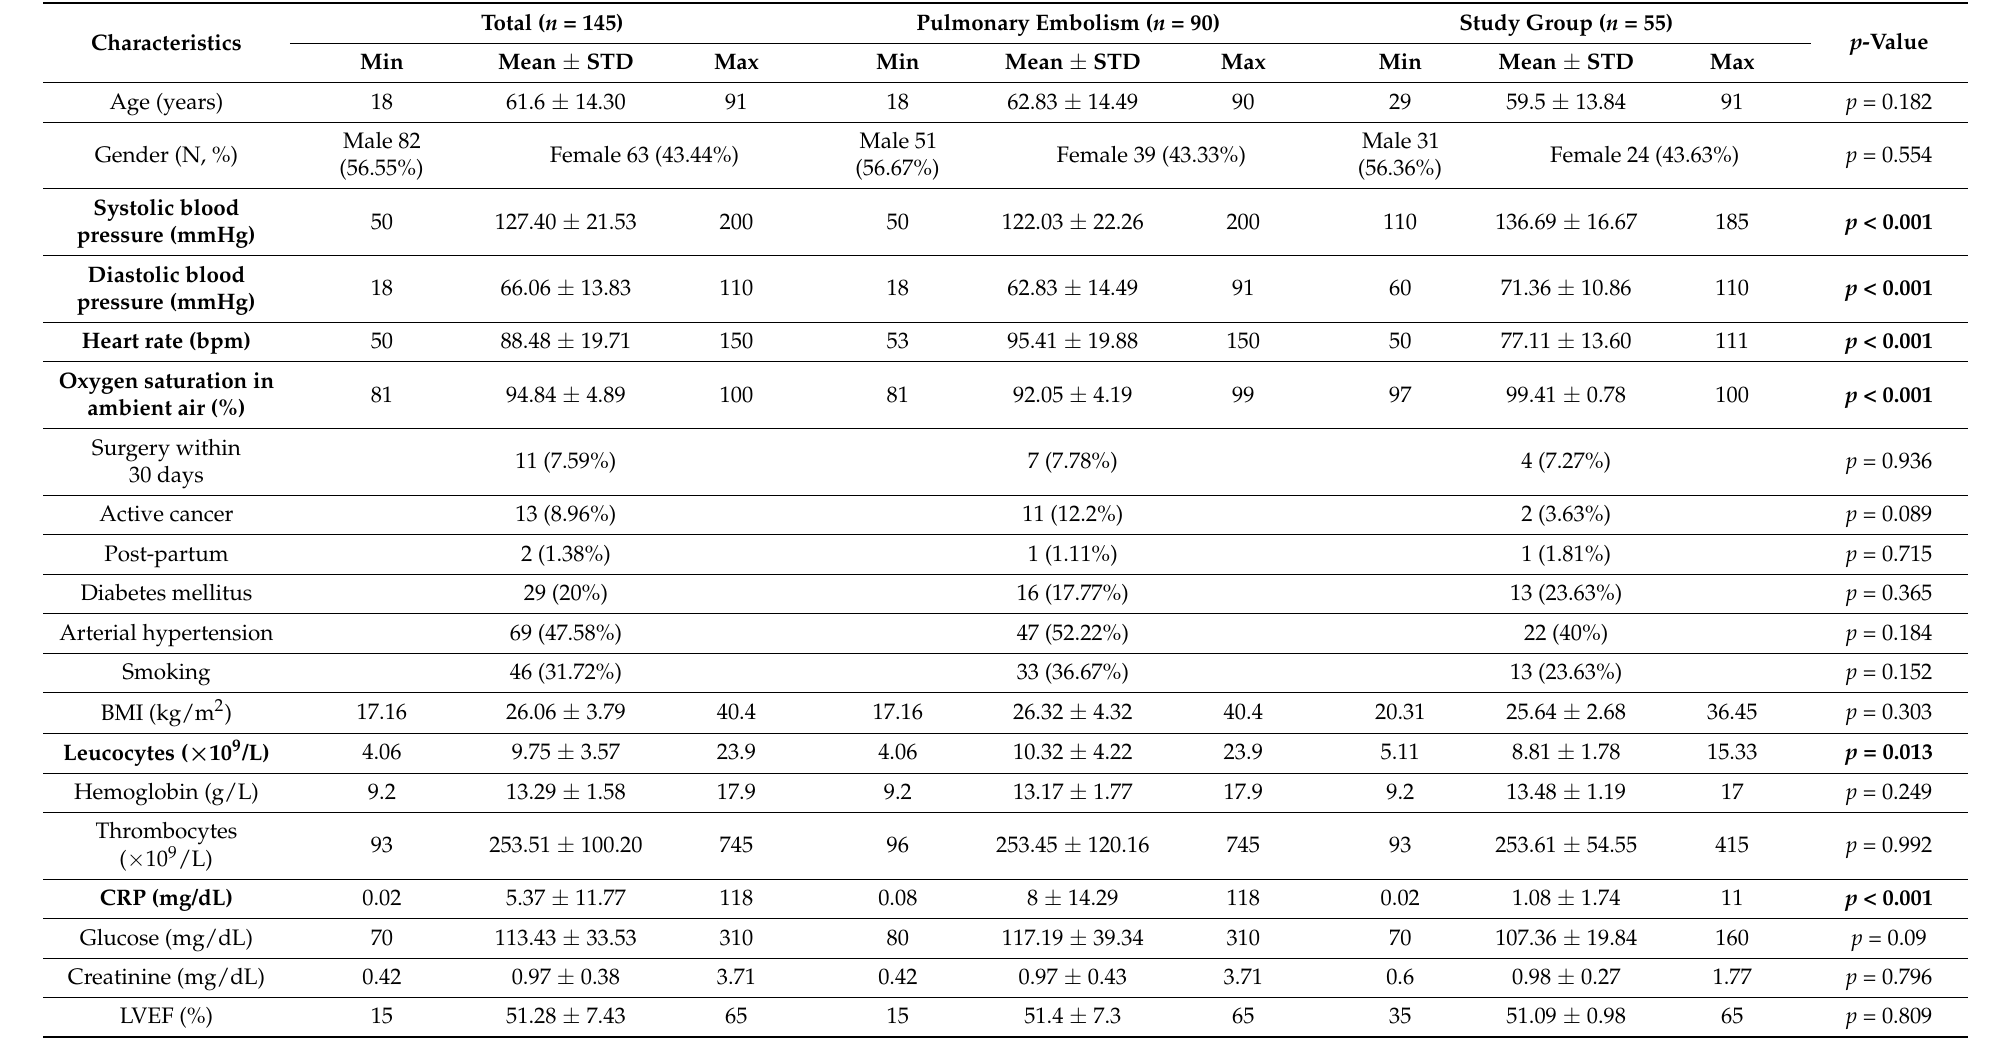
Table 1. General characteristics of the study